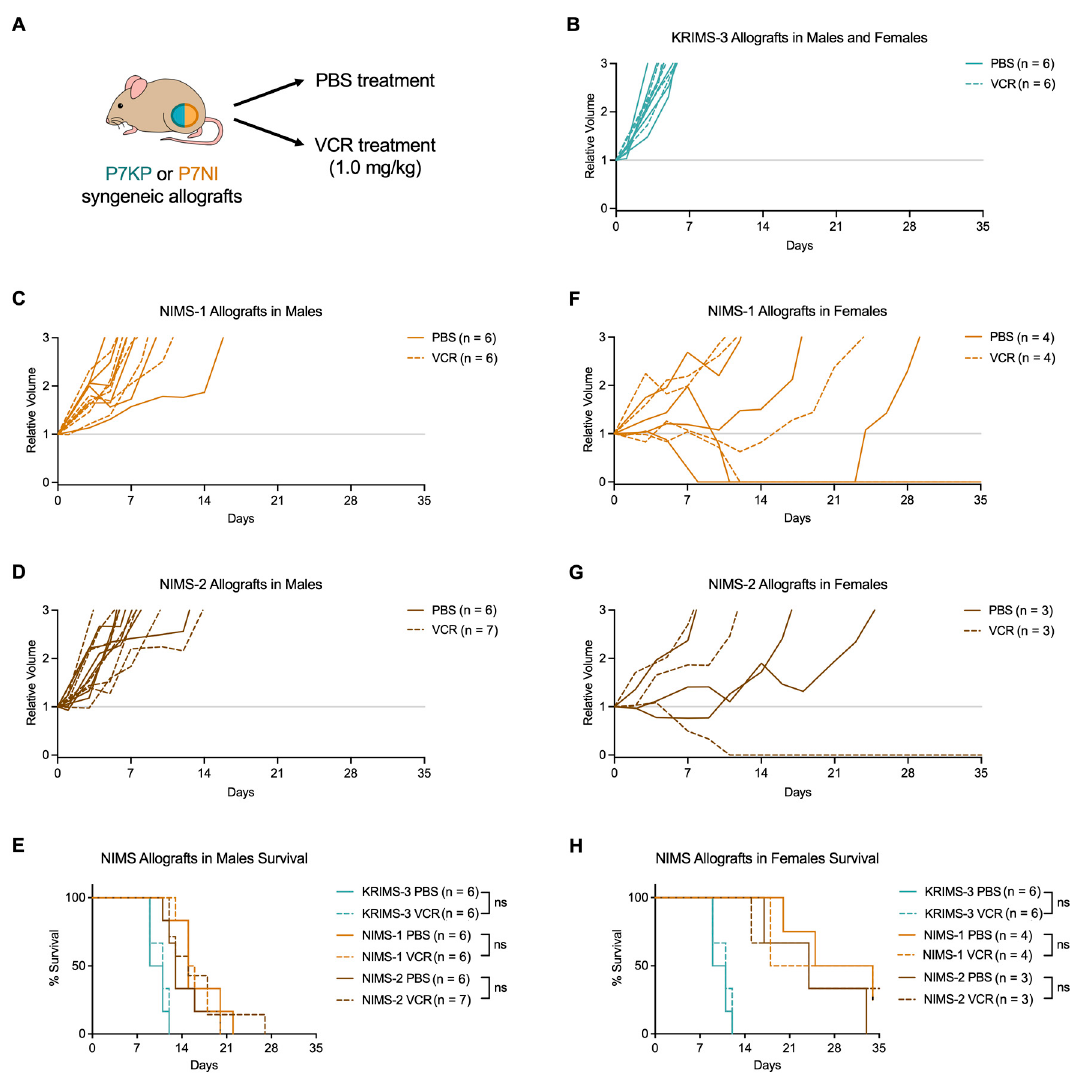
Figure 4. Impact of vincristine on allograft growth. ( A ) Mice were treated with one dose of saline (PBS) or vincristine (VCR) at the time of tumor initiation. ( B ) Individual growth curves for KRIMS-3 allografts in male and female mice. ( C , D ) Individual growth curves for NIMS-1 and NIMS-2 allografts in male mice. ( E ) Survival of NIMS-1 and NIMS-2 allografts in male mice and KRIMS-3 allografts in male and female mice. ( F , G ) Individual growth curves for NIMS-1 and NIMS-2 allografts in female mice. ( H ) Survival of NIMS-1 and NIMS-2 allografts in female mice and KRIMS-3 allografts (same KRIMS-3 allografts shown in D ). Log-rank (Mantel-Cox) test used to analyze sets of PBS versus VCR treated in mice E and H. ns = not significant.